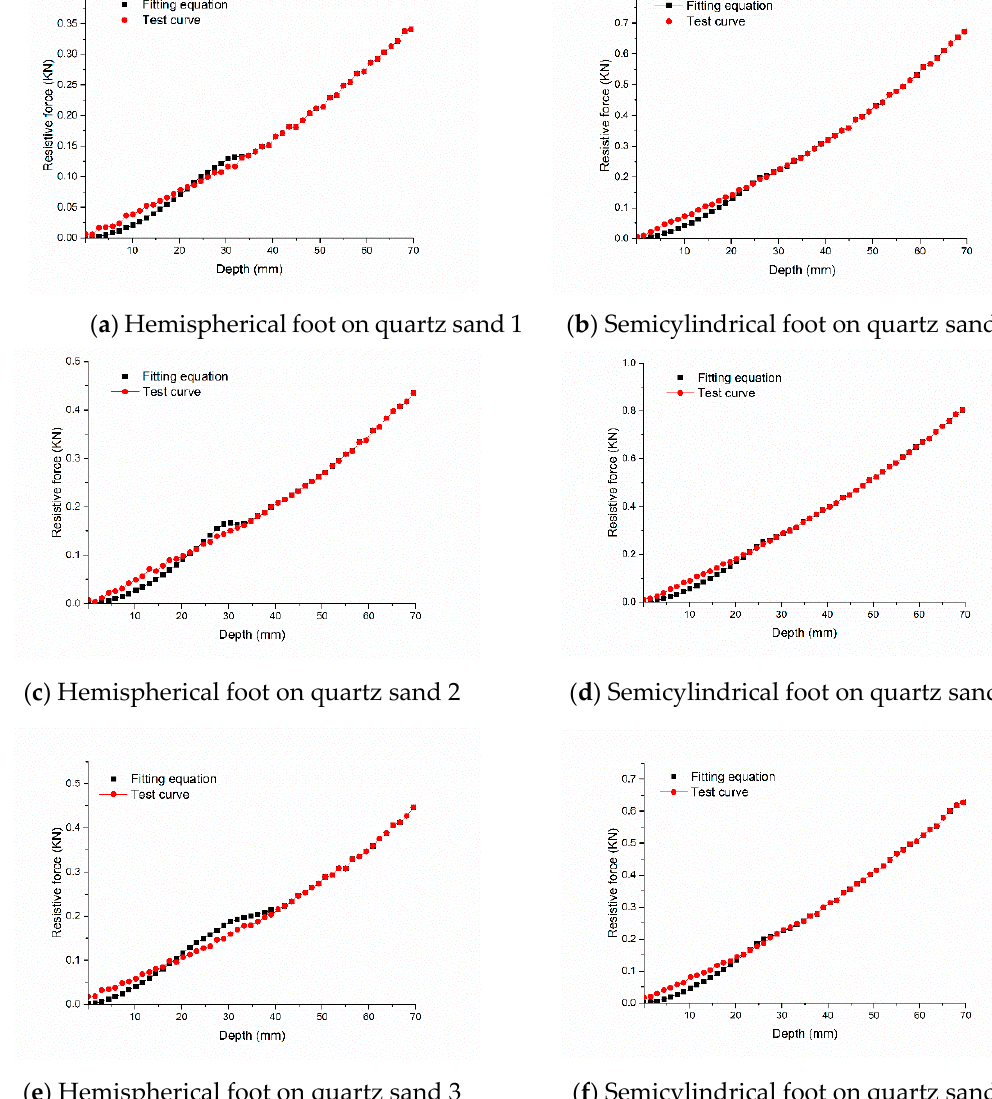
Figure 14. Modified mechanical model evaluation.